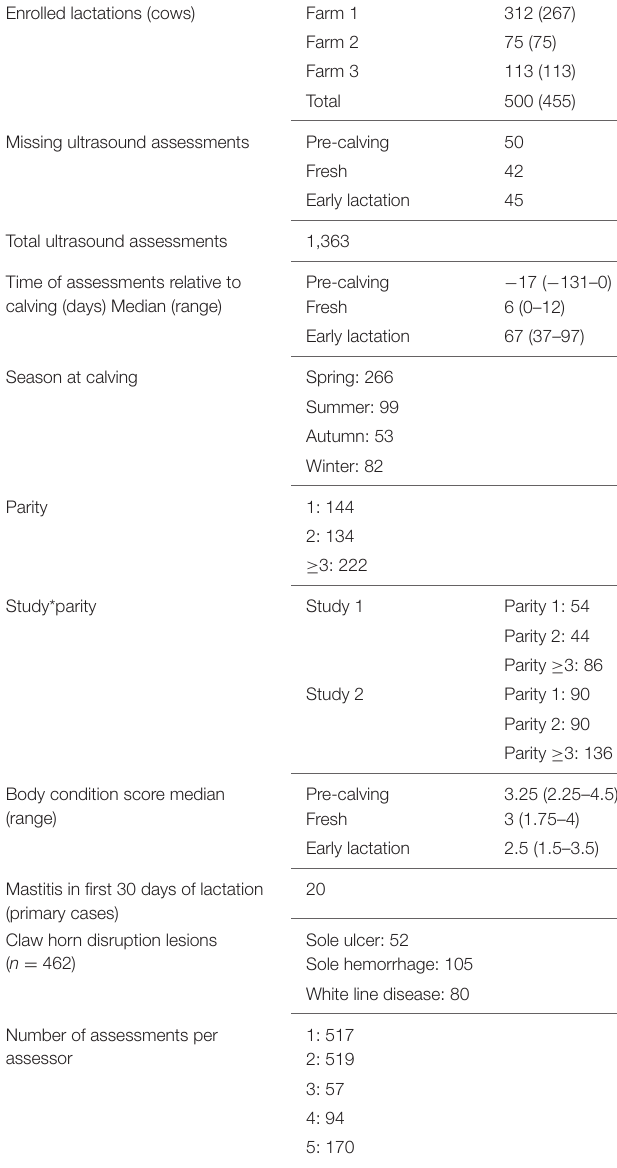
TABLE 1 | Summary data for study